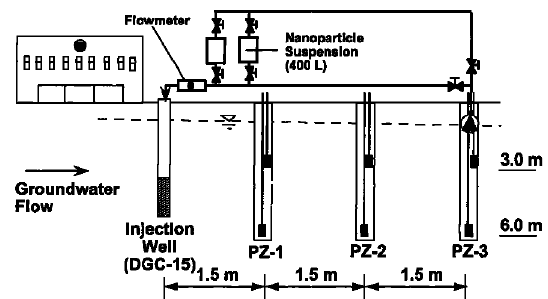
Figure 5. Scheme of the injection set-up. Reprinted with permission from Elliot et al. [99] Copyright (2001) American Chemical Society.